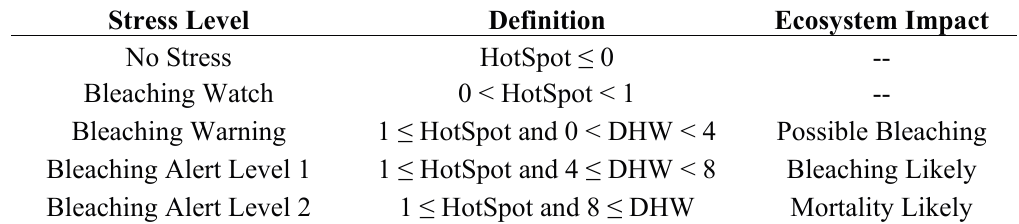
Table 2. CRW’s coral bleaching thermal stress levels based on Coral Bleaching HotSpots and Degree Heating Weeks (DHW)